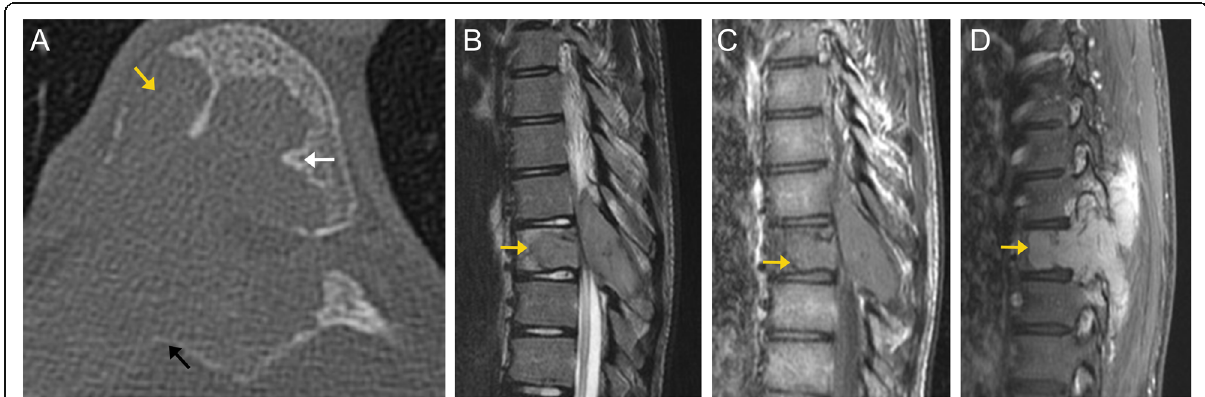
Fig. 7 Osteoblastoma. Axial ( a ) CT image of the thoracic spine demonstrates a lytic lesion involving the T7 vertebral body (orange arrow) and posterior elements, with an expansile soft tissue component. A thin sclerotic rim can be seen along the border of the intervertebral portion of the lesion (white and black arrows). Sagittal T2 ( b ), T1 pre-contrast ( c ), and T1 post-contrast ( d ) MR images again demonstrate a lesion involving the T7 vertebral body and posterior elements (orange arrows), as well as invasion of the adjacent paraspinal soft tissues. The lesion is predominantly low to intermediate signal compared to normal marrow, and demonstrates avid enhancement on post-contrast images